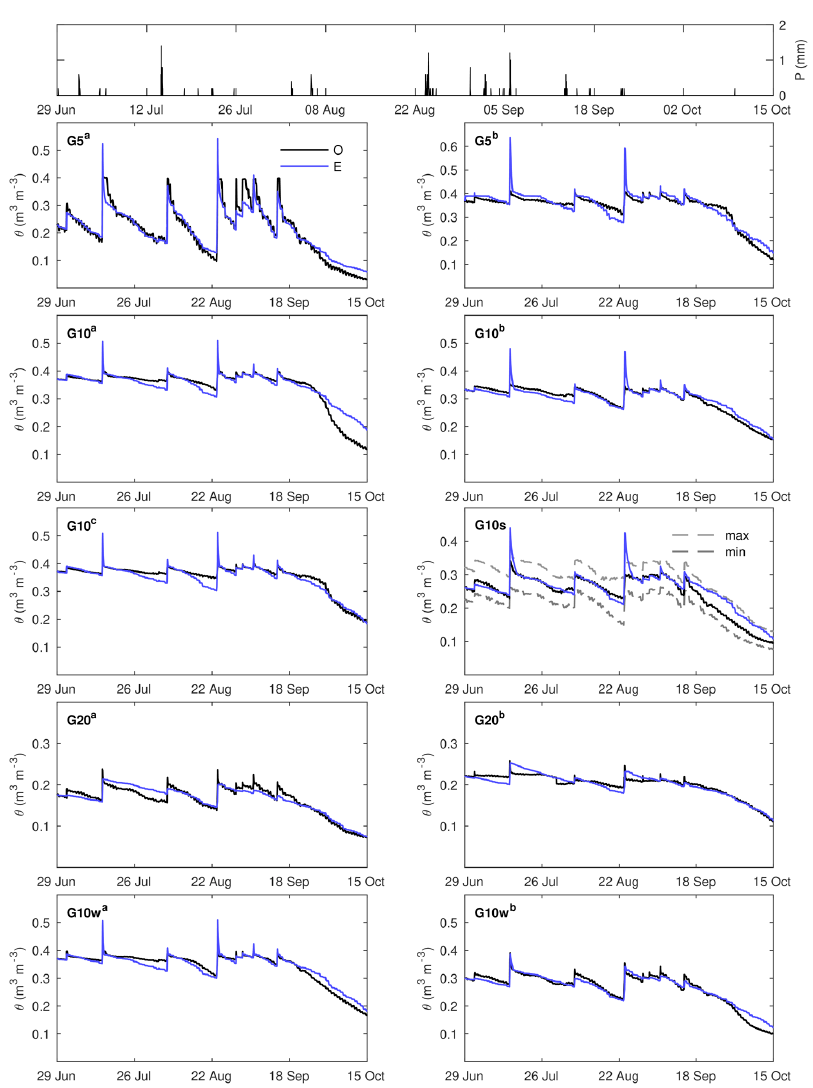
Figure 3. Observed (O) (black lines) and estimated (E) (blue lines) substrate moisture during calibration process (rainy season 2014). A precipitation hyetograph is also presented.